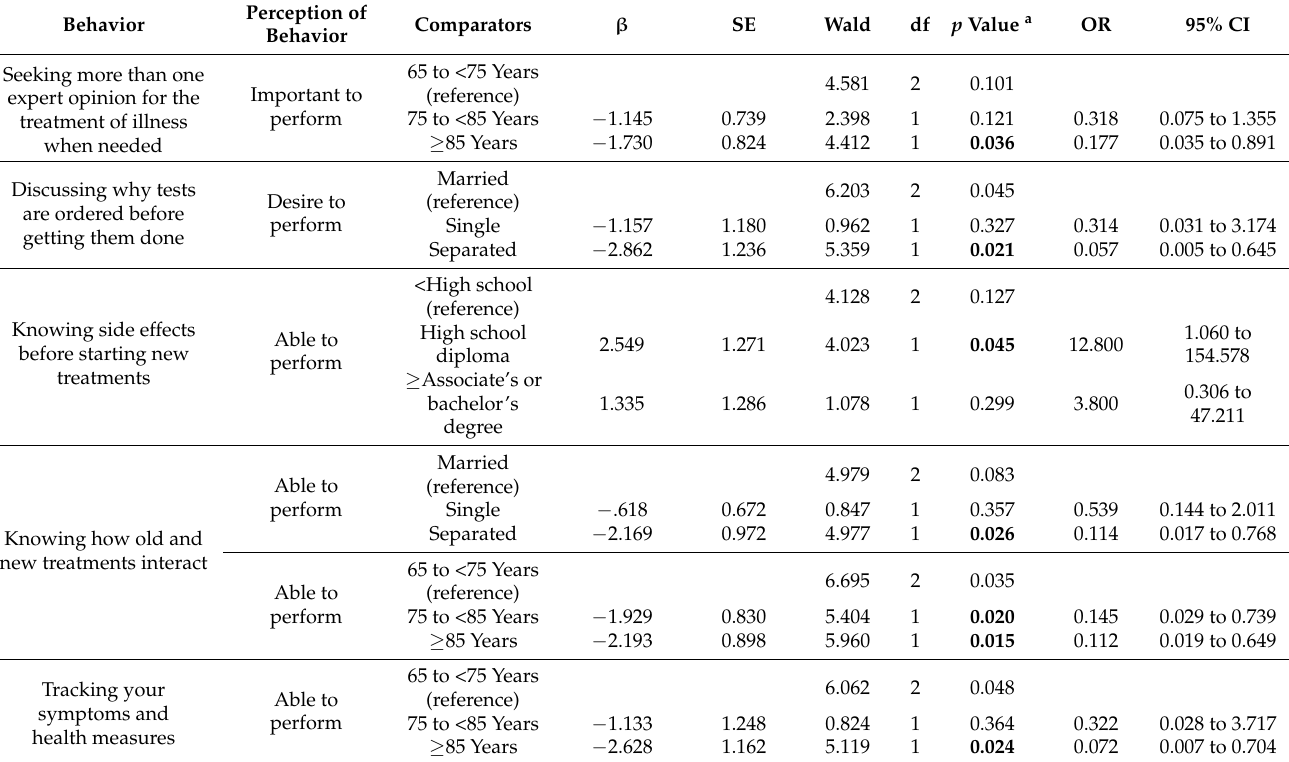
Table 3. Univariate logistic regression predicting the likelihood of a “yes” response to a perception about performing a self-care